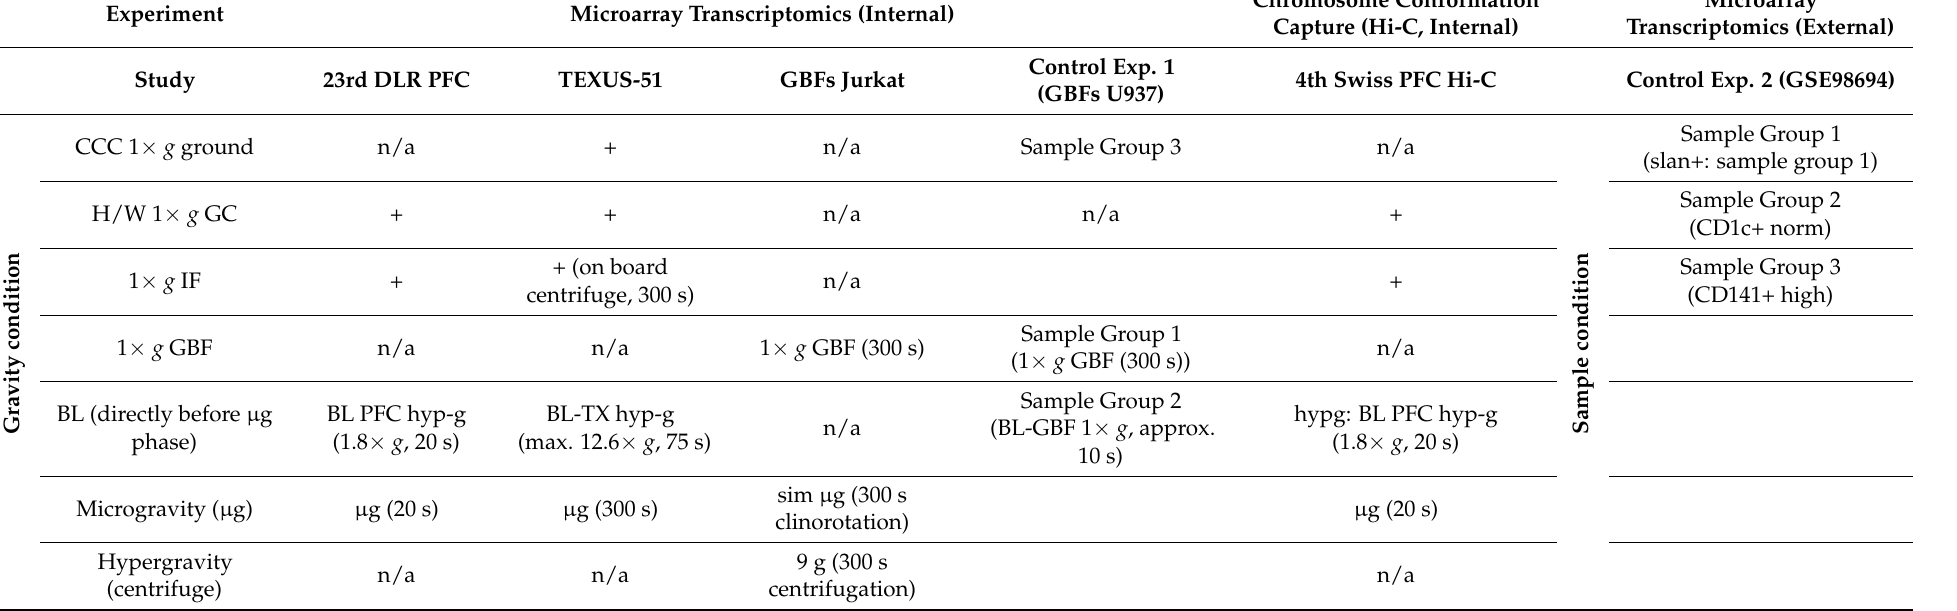
Table 1. Overview of sample nomenclature for microgravity platforms and GBFs applied in different experimental research studies. Datasets generated by our experiments are “internal”, and publicly available datasets are “external”. Gravity conditions and times are given for parabolic flights, sounding rockets, and GBF experiments. GBF, ground-based facility; PFC, parabolic flight campaign; TX, TEXUS mission; Exp, Experiment; 1CCC, cell culture control; H/W, hardware; IF, in-flight; BL, baseline; hyp-g, hypergravity; µ g, microgravity; n/a, not